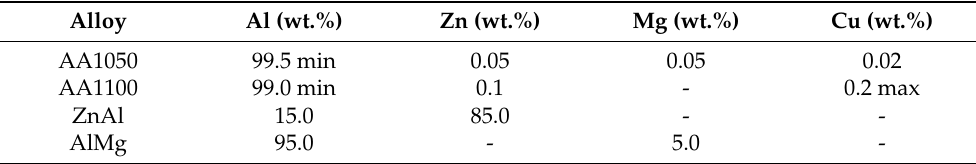
Table 2. Chemical composition in weight % of alloys used for thermal spray coatings.